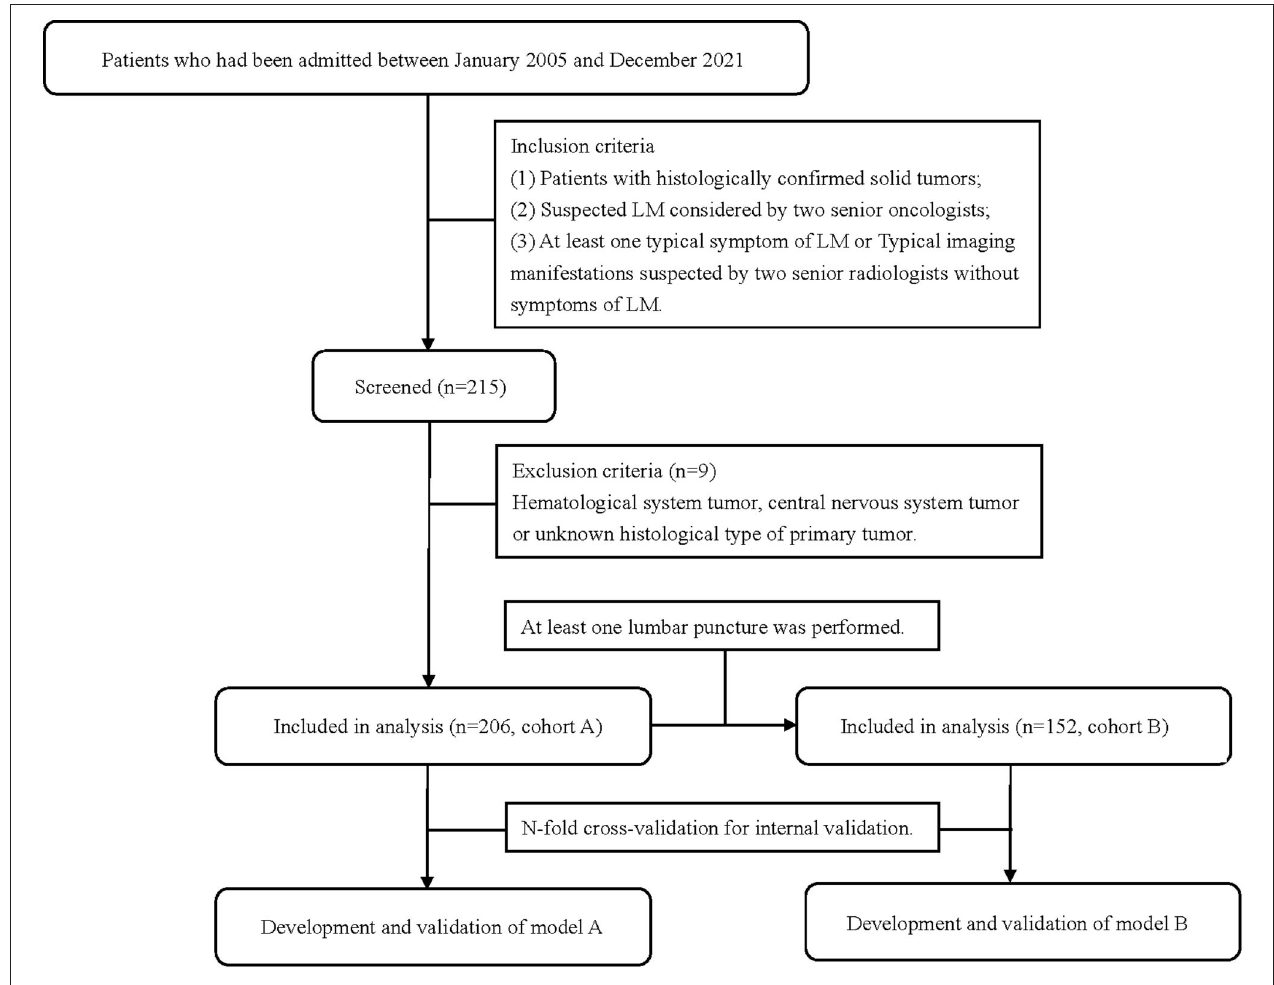
FIGURE 1 | Flow chart of the study